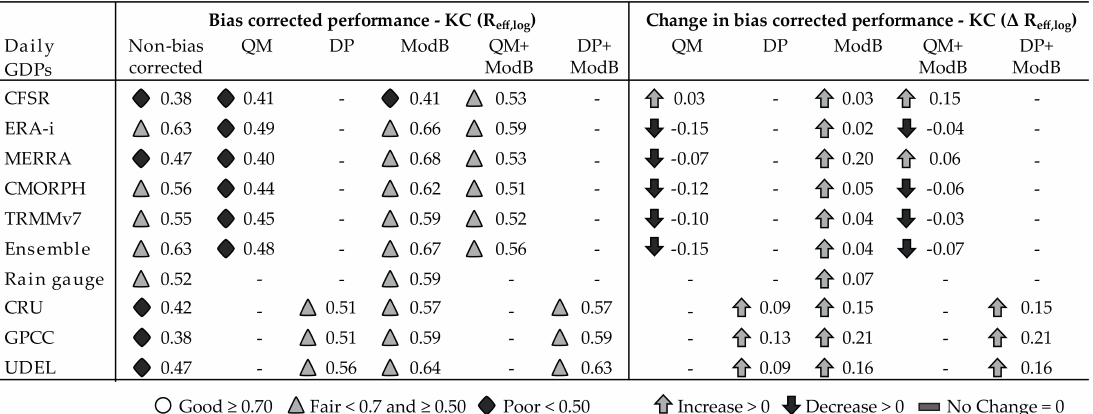
Table 6. Performance scores for KC discharge simulations. Performance is shown as R eff , log values for each bias correction technique